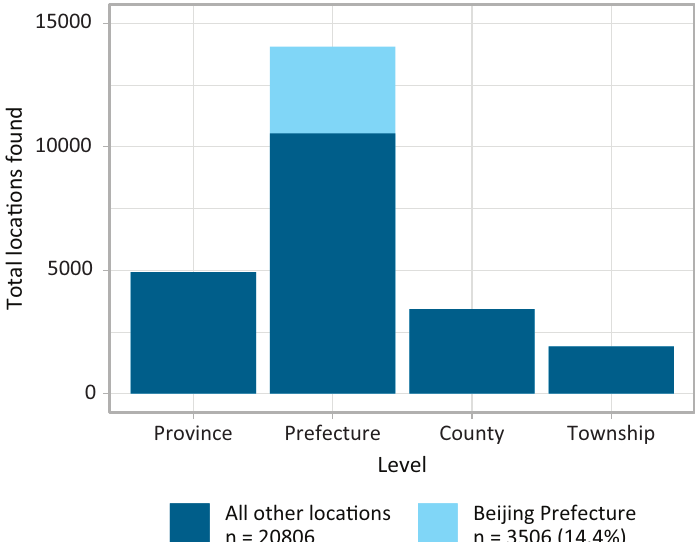
Figure 2. Locations recorded by administrative level in all articles. Notes: n = 24,312. Prefectures were the most commonly mentioned administrative level. Beijing City, the only prefecture in the Provincial‐level entity of the same name, was the most commonly mentioned entity.